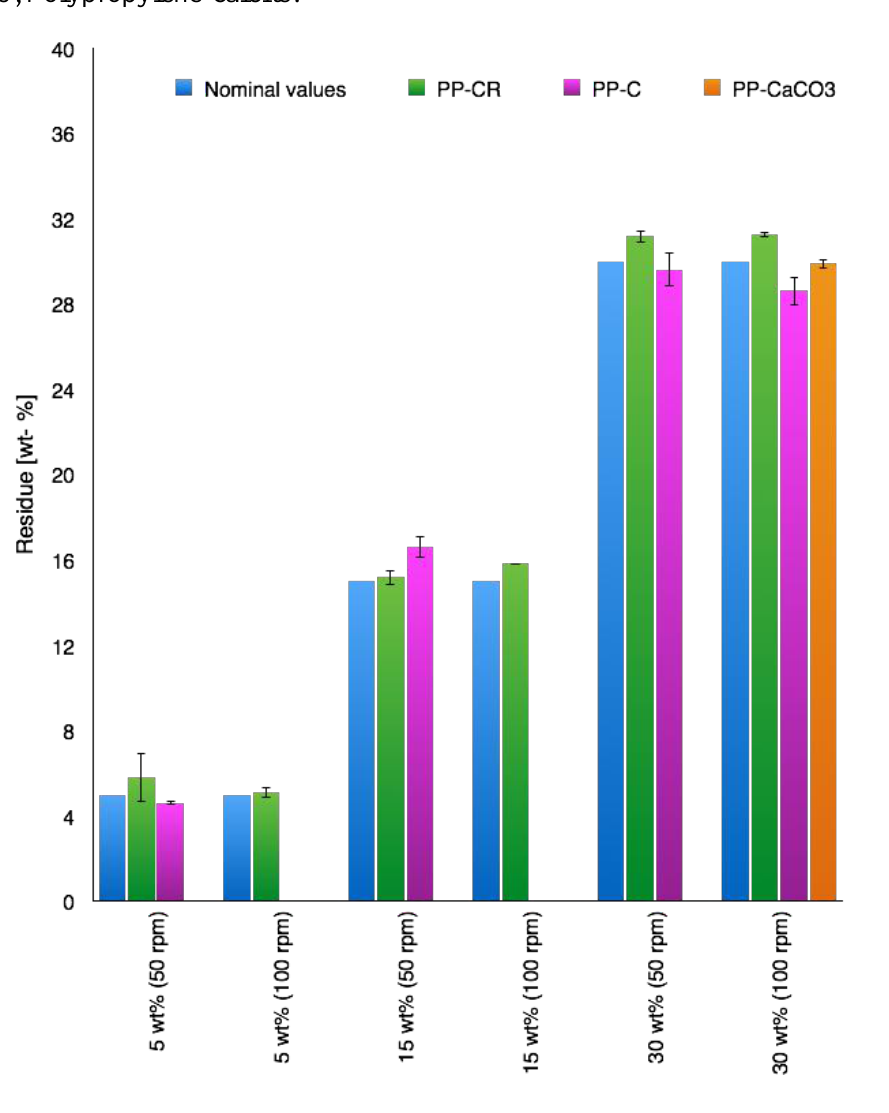
Figure 1. Calculated residue for the composites obtained by varying filler and processing conditions, measured by thermogravimetric analysis (TGA) at 800 °C (air) and considering pristine component values evaluated at the same temperature. PP-CR, Polypropylene-COSMOS-RICE; PP-C, Polypropylene-COSMOS; PP-CaCO3,